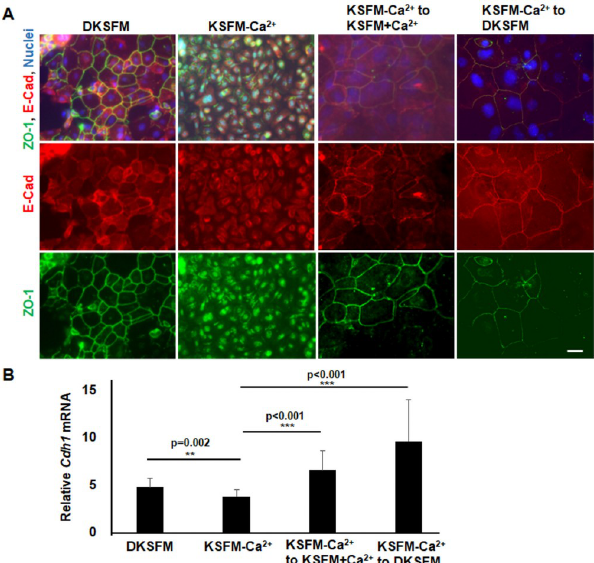
Fig 3. Formation of cell-cell junctions depends on extracellular calcium. (A) Primary keratinocytes grown in DKSFM and cell lines grown in KSFM-Ca 2+ with or without switching to DKSFM and KSFM+Ca 2+ media for 48 h were examined (A) by immunofluorescence staining using anti-E-Cad and anti-ZO-1, and (B) by qPCR for mRNA of E-Cadherin ( Cdh1) compared to the level in mESCs as 1. Data represent at least triplet samples +/-SD. Scale bar represents 20 μ